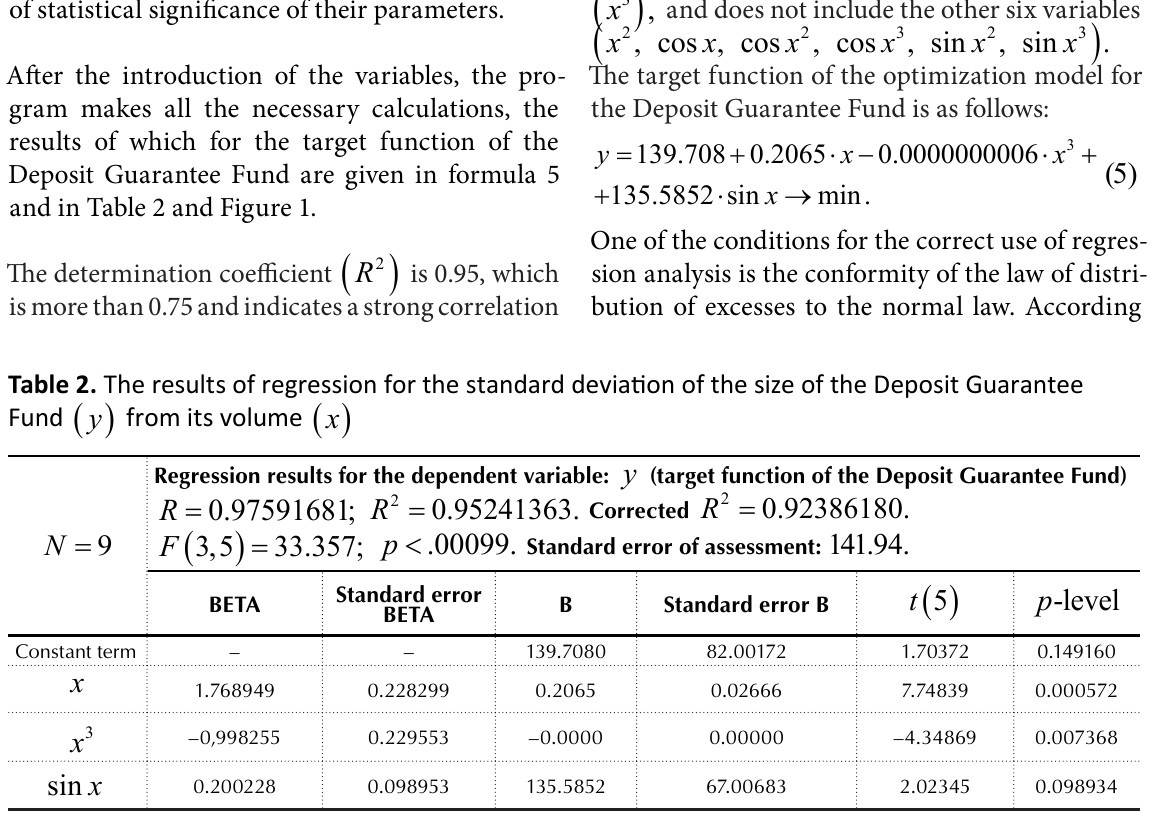
equations (multiple nonlinear regression): for the target function and the first three constraints of